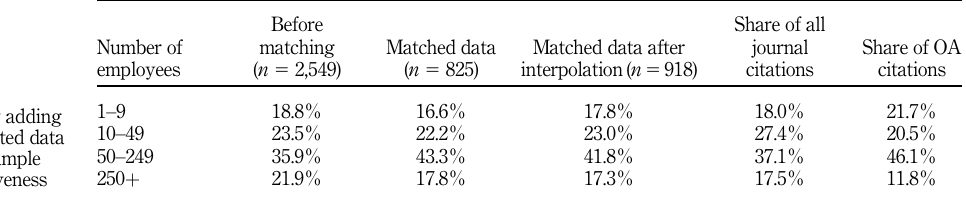
Table 1. Data on how adding the interpolated data influences sample